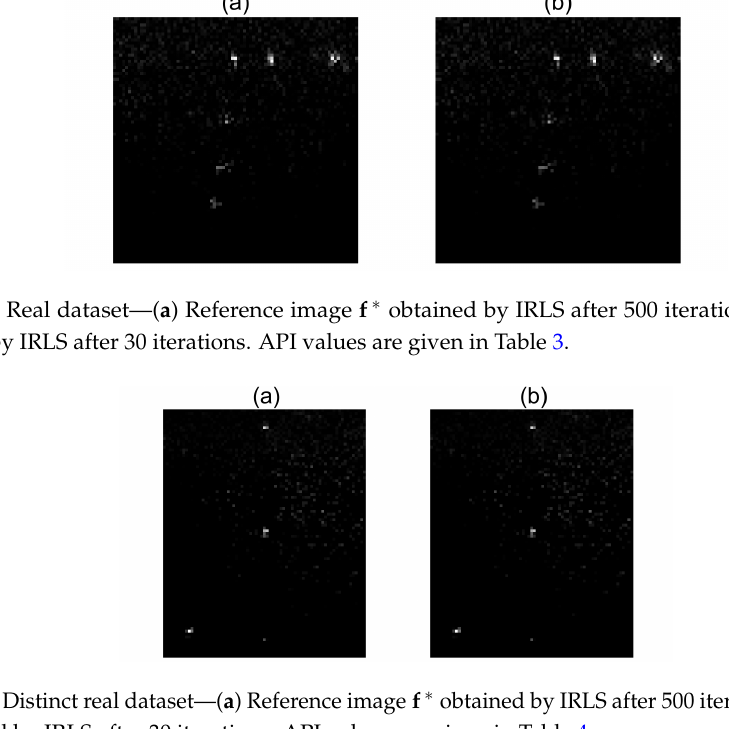
Figure 25. Distinct real dataset—( a ) Reference image f ∗ obtained by IRLS after 500 iterations; ( b ) Image ˆ f k obtained by IRLS after 30 iterations. API values are given in Table